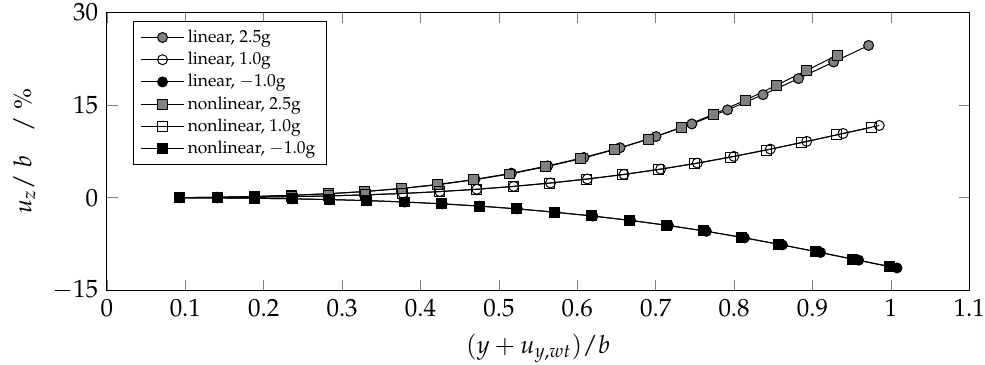
Figure 7. Bending deformation over spanwise position normalised by reference half span for a transport aircraft